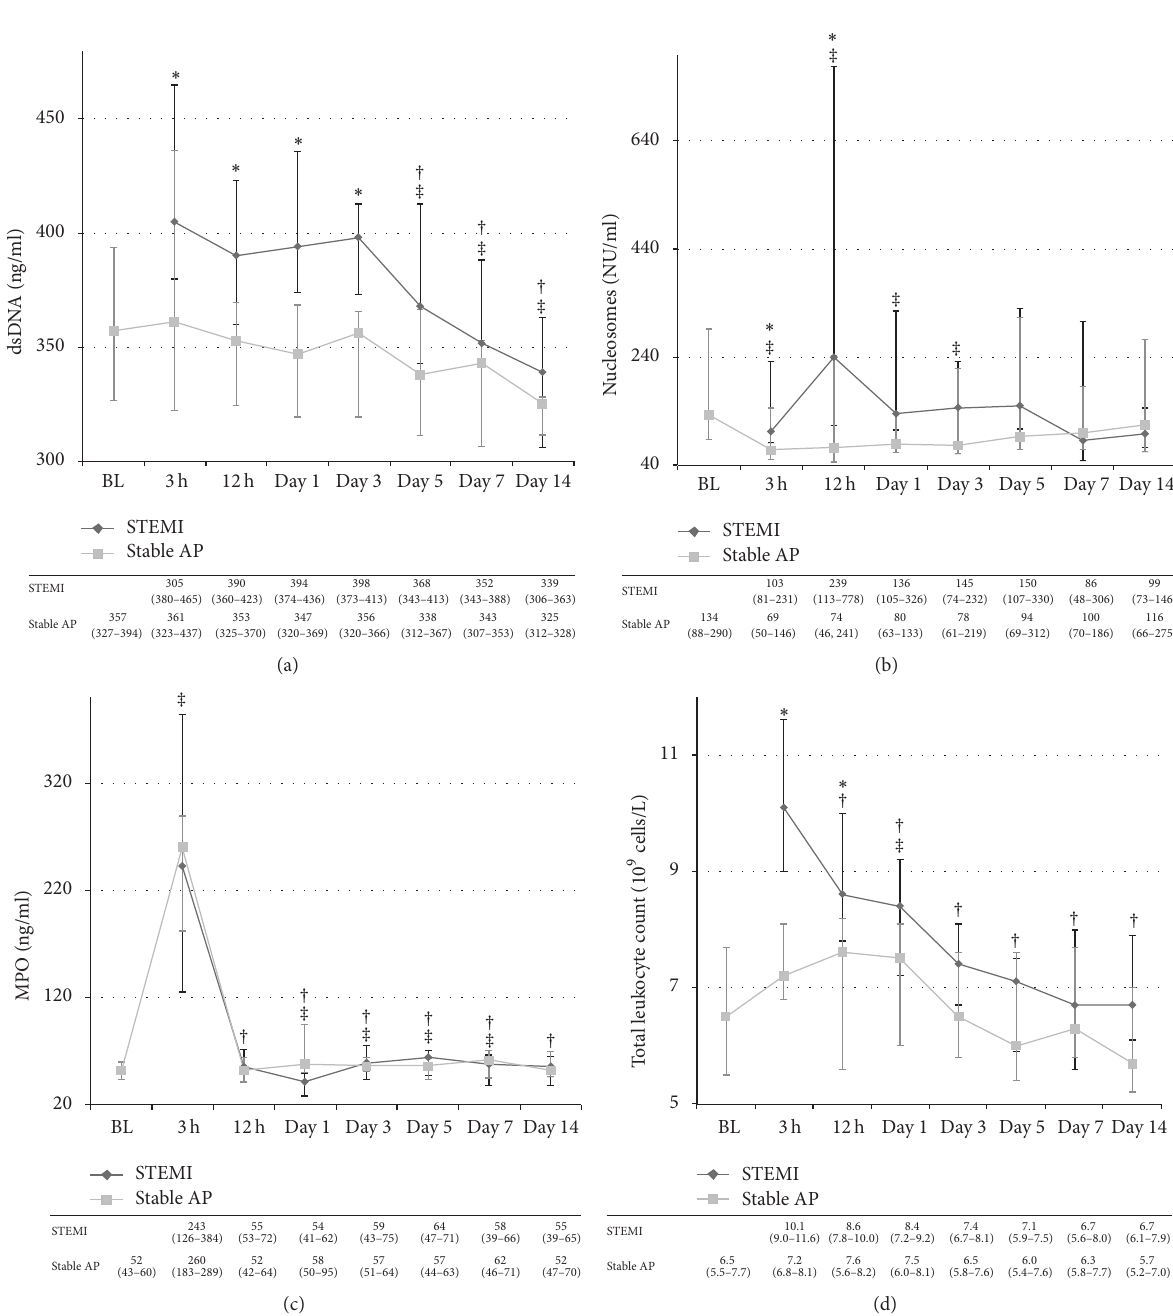
Figure 1: Time profiles of the NETs markers, myeloperoxidase, and leukocyte count. (a) Double-stranded deoxyribonucleic acid (dsDNA), (b) nucleosomes (DNA-histone complexes), (c) myeloperoxidase (MPO), and (d) total leukocyte count. The various time points ( 𝑥 -axis) and levels ( 𝑦 -axis) in the ST-elevation myocardial infarction (STEMI) and stable angina pectoris (AP) groups, as well as between- and within- group comparisons. Values are given as median (25–75 percentiles). BL: baseline. ∗ 𝑝 < 0.05 for between-group difference at the various time points. † 𝑝 < 0.05 for within-group difference from 3 hours in the STEMI group. ‡ 𝑝 < 0.05 for within-group difference from baseline in the stable AP